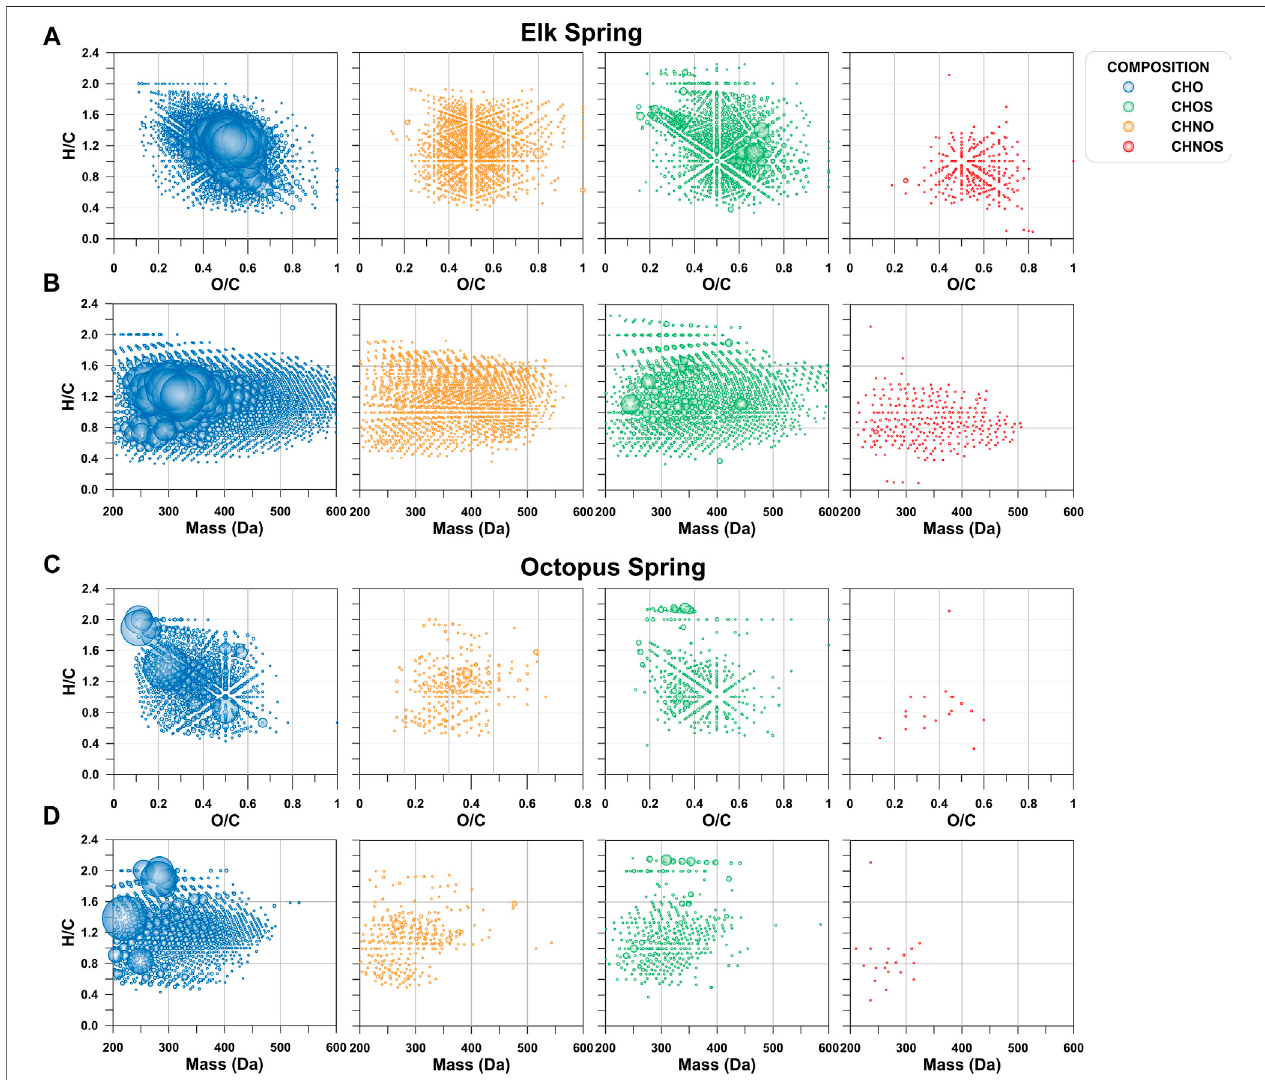
FIGURE 7 | Van Krevelen and mass-edited hydrogen to carbon ratio (H/C) diagrams as a function of elemental composition. (A) van Krevelen diagram for Elk Spring. (B) . Mass-edited H/C diagram for Elk Spring. (C) . van Krevelen diagram for Octopus Spring. (D) . Mass-edited H/C diagram for Octopus Spring.